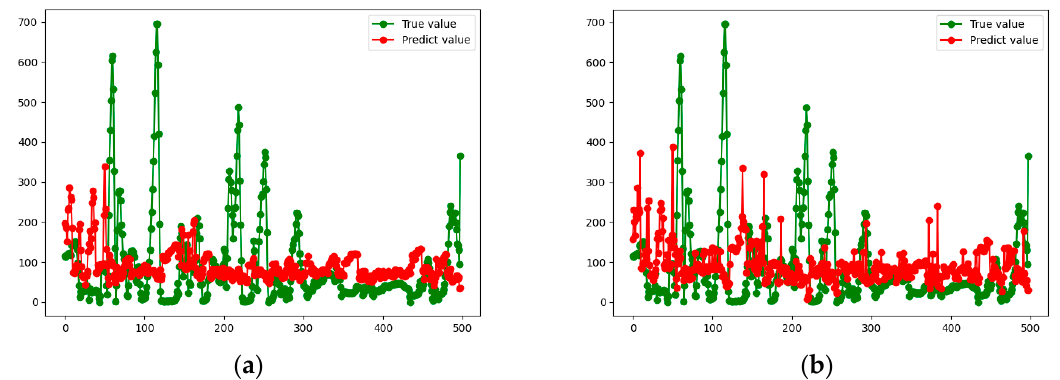
Figure 9. The prediction results by RF ( a ) and GBDT ( b ) for the vehicle of ***R580.